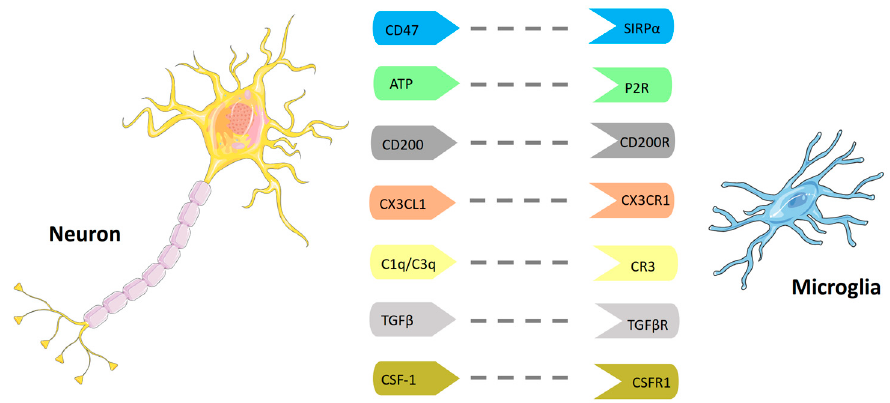
Figure 2. Cross-talk between microglia and neurons. This figure was drawn using the vector image bank of Servier Medical Art (http://smart.servier.com/). Servier Medical Art by Servier is licensed